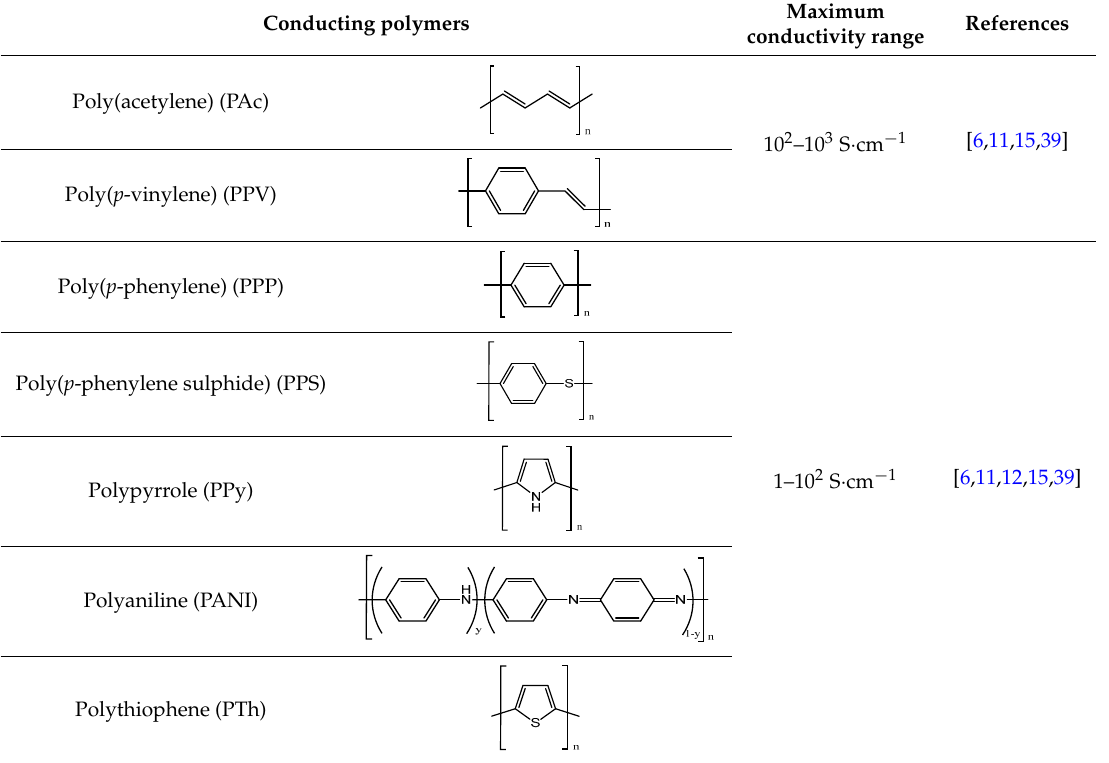
Table 1. Structures and maximum conductivity range for some of most commonly used EAPs in doped form.